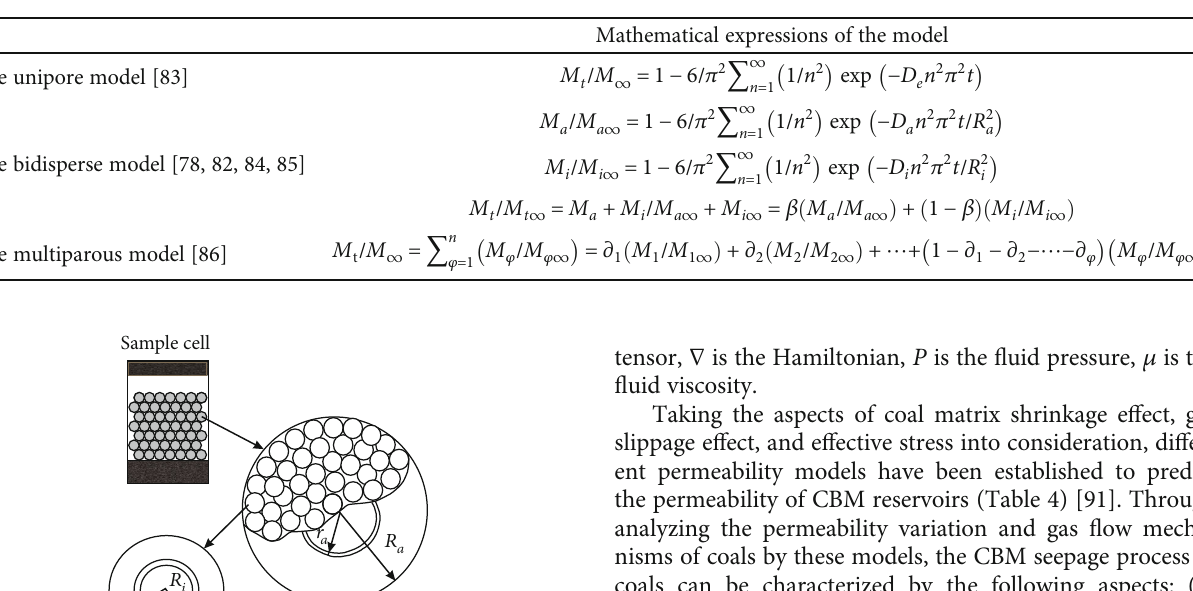
Table 3: CBM di ff usion models and mathematical expressions.